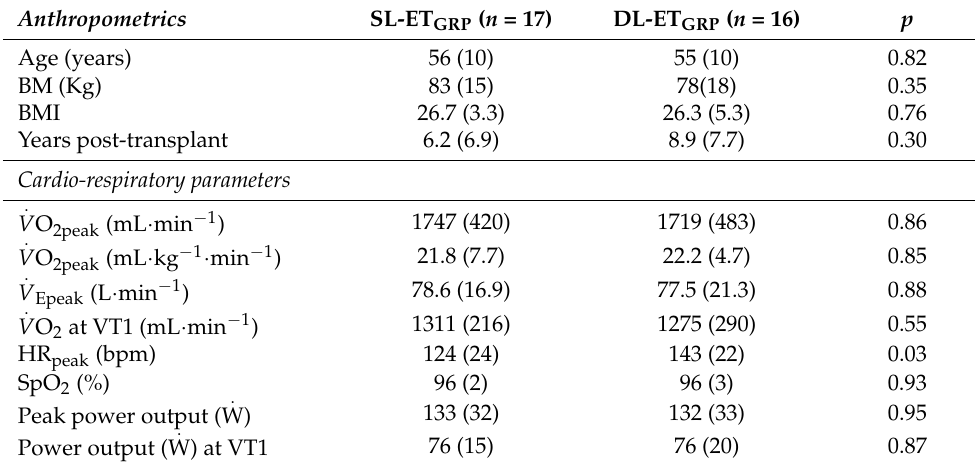
Table 1. Main anthropometrics, cardio-respiratory, and cardiovascular parameters assessed during the double leg incremental test measured before the training period. Single leg endurance training group (SL-ET GRP ) and double leg endurance training group (DL-ET GRP ) groups.